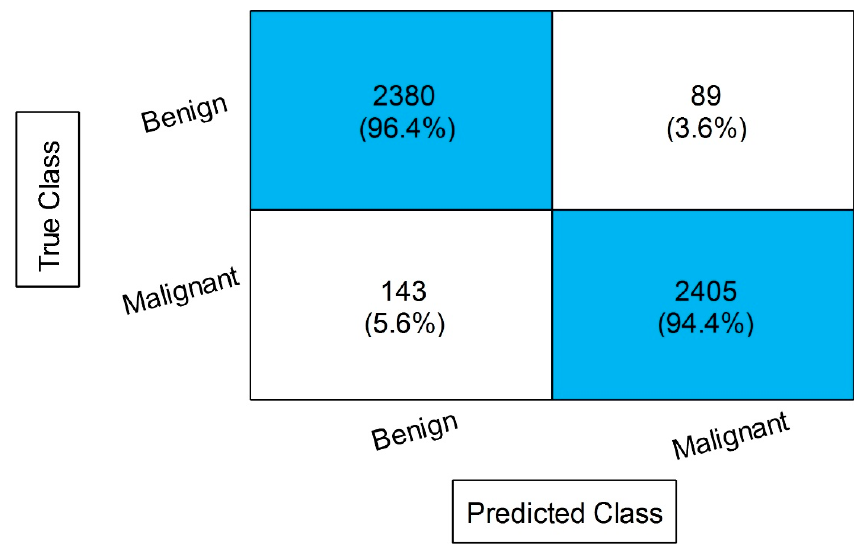
Figure 10. Confusion matrix of ESKNN classi fi er using proposed feature selection method.